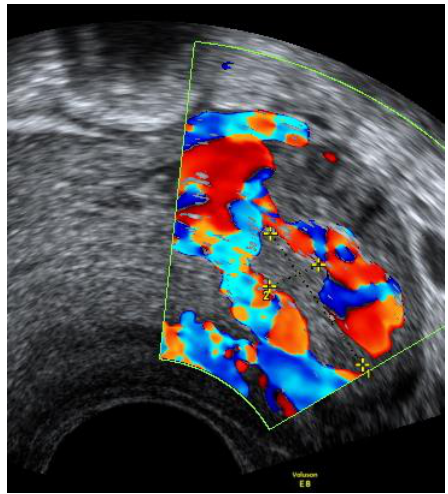
Figure 8. Left cornu of the uterus visualized by transvaginal ultrasonography 30 days postpartum.